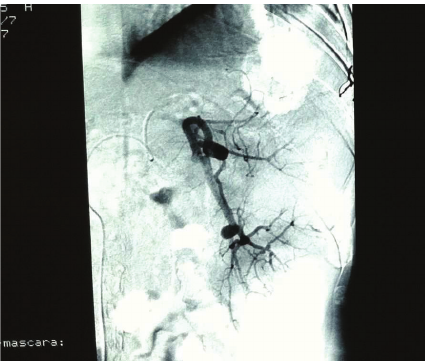
Figure 1: Splenic arteriography.